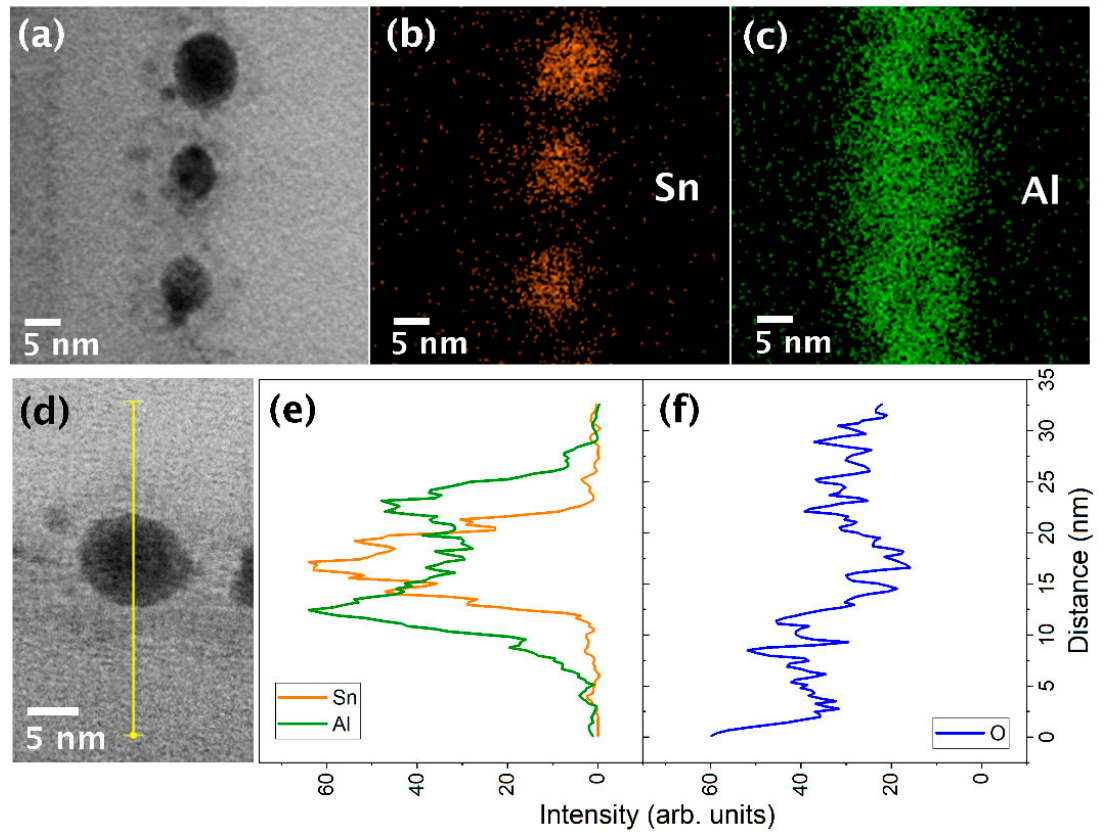
Figure 3. ( a ) TEM image used for the EDX mapping scans; ( b , c ) mapping images of Sn (yellow line) and Al (green line), respectively; ( d ) TEM image and guide line for the EDX line scans; ( e ) EDX line scanning spectra of Sn and Al; and ( f ) EDX line scanning spectrum of O.